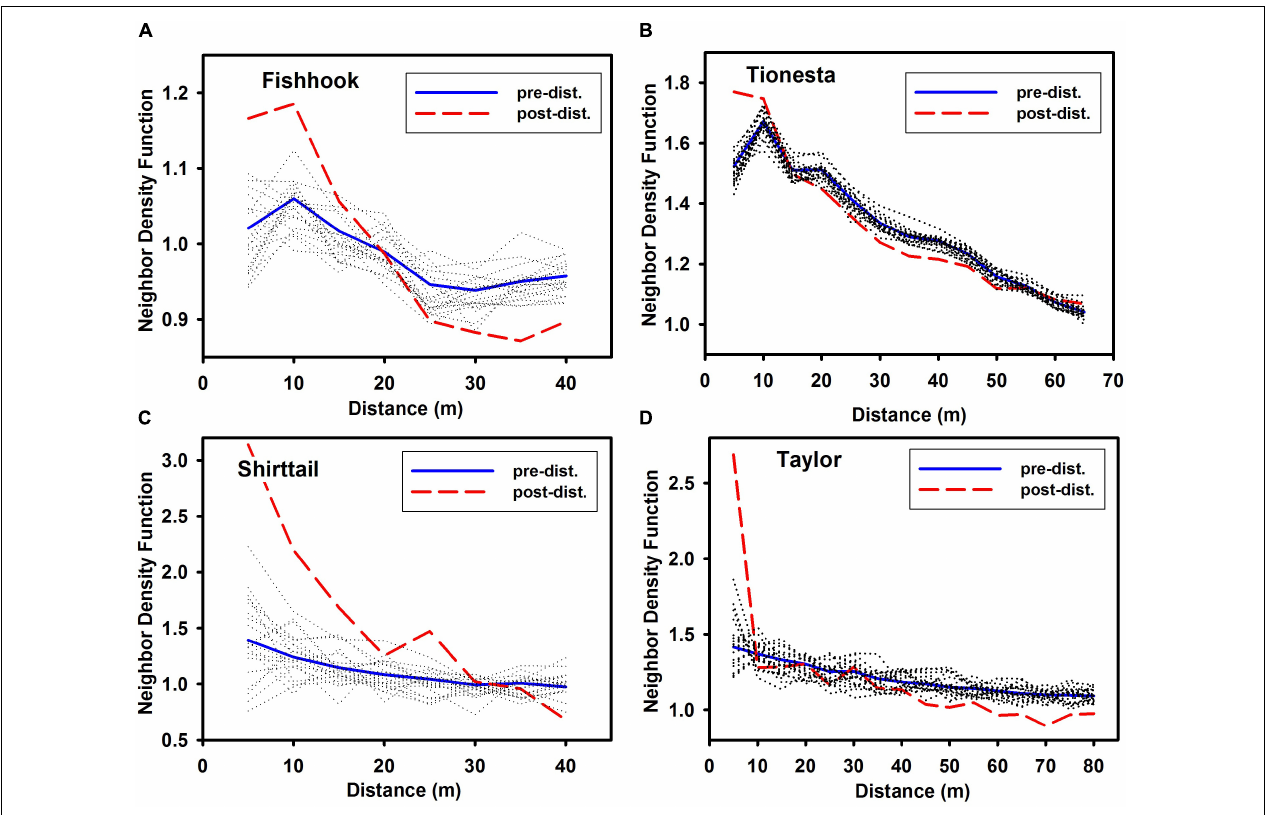
FIGURE 6 | Neighbor density function of pre-disturbance standing trees and post-disturbance standing trees at the four sites. (A) Fishhook; (B) Tionesta; (C) Shirttail; and (D) Taylor. Note that x and y axes differ among the panels in this figure. As in Figure 4 , dotted lines show the NDF for 20 separate random selections from among the pre-disturbance trees, with n = the number of surviving (standing post-disturbance) trees at that site. Values at any given distance that are outside the extremes of the 20 randomizations indicate that the spatial pattern of survivor trees is significantly non-random, given the pre-disturbance distribution of trees. Values greater than highest randomized NDF at that distance are more aggregated than random; values less than the lowest randomized NDF at that distance are more uniform than